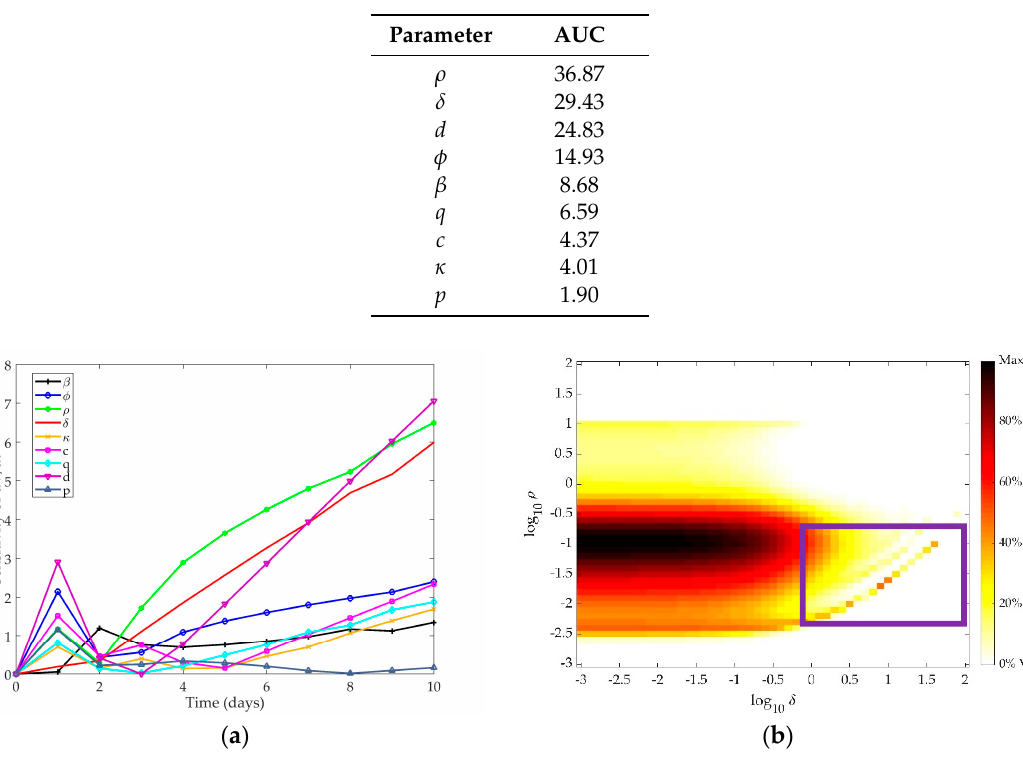
( a ) Time-dependent sensitivity of virus to each parameter in the Pawelek model; ( b ) Two-dimensional sensitivity of Pawelek model to two most sensitive parameters: ρ and δ . Colors correspond to the amount of virus present at ten days post-infection in simulation as a fraction of the maximum virus concentration observed. Darker colors correspond to a higher level of virus present at day 10, while lighter colors indicate a low level of virus present in the system after ten